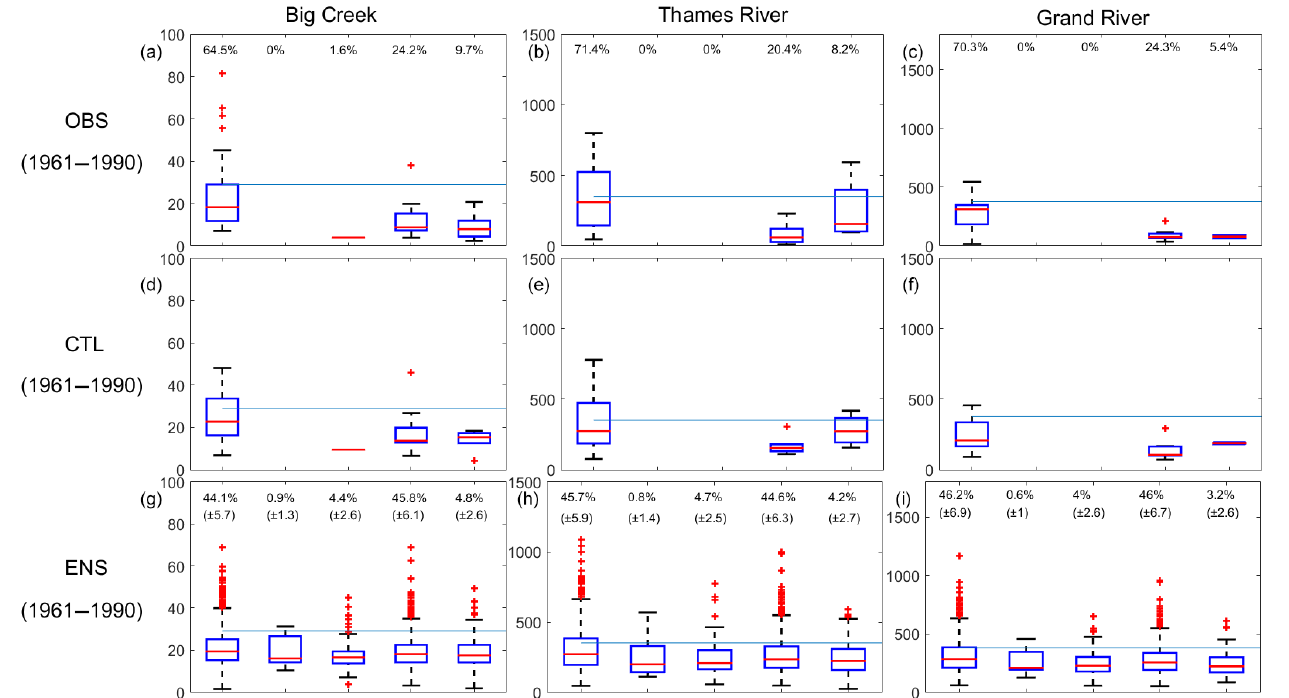
Figure 7. Upper and middle panels: distribution of observed (OBS) and simulated (CTL) streamflow corresponding to all observed heavy rain and warm events. Lower panels: distribution of simulated streamflow corresponding to all simulated heavy rain and warm events pooled for all members (ENS). Boxes extend from the 25th to the 75th percentile, with a horizontal red bar showing the median value. The whiskers are lines extending from each end of the box to the 1.5 interquartile range. Plus signs correspond to outliers. The horizontal blue lines correspond to the high-flow threshold (99th